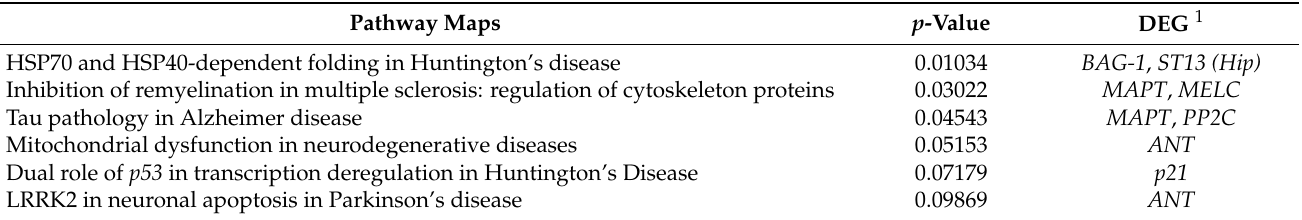
Table 6. Pathway maps with DEG between SOY1.5 vs. SOY3.0 in liver tissue enriched in significant pathways ( p -value <